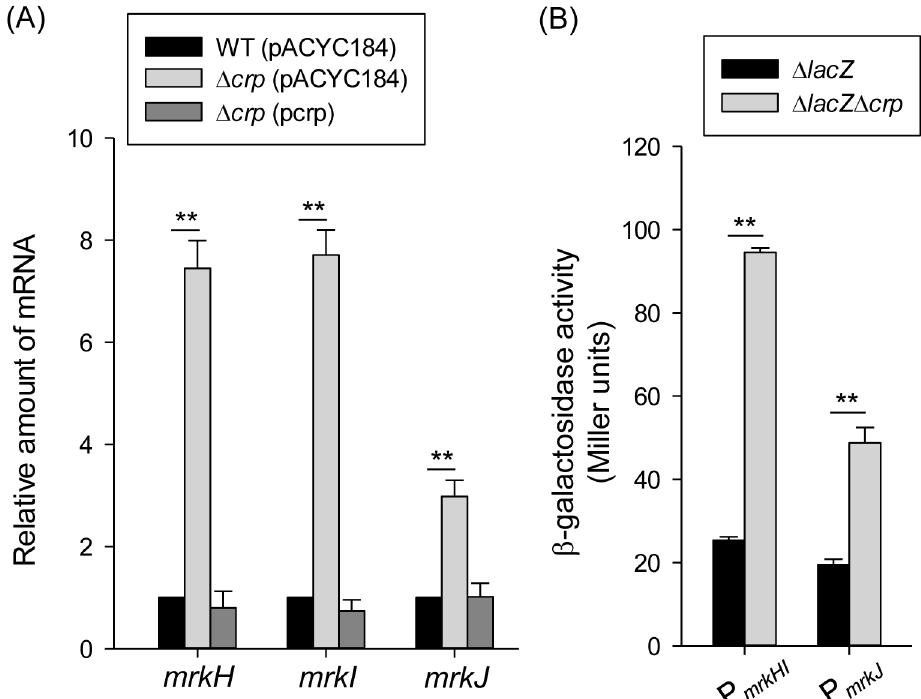
Fig 3. CRP represses the mrkHIJ expression. (A) qRT-PCR analysis of mrkH , mrkI , and mrkJ expression was measured in WT (pACYC184), Δ crp (pACYC184), and Δ crp (pcrp) strains in LB medium. (B) β - galactosidase activities of K . pneumoniae CG43S3 Δ lacZ and the isogenic strain ( Δ lacZ Δ crp ) carrying the reporter plasmids pmrkHIZ15 (P mrkHI :: lacZ ) and pmrkJZ15 (P mrkJ :: lacZ ) were determined using log-phase cultures grown in LB medium. The results are representative of three independent experiments. Error bars indicate standard deviations. * P < 0.05 and ** P < 0.01 compared to WT (pACYC184) (A) and CG43S3 Δ lacZ (B) strain.